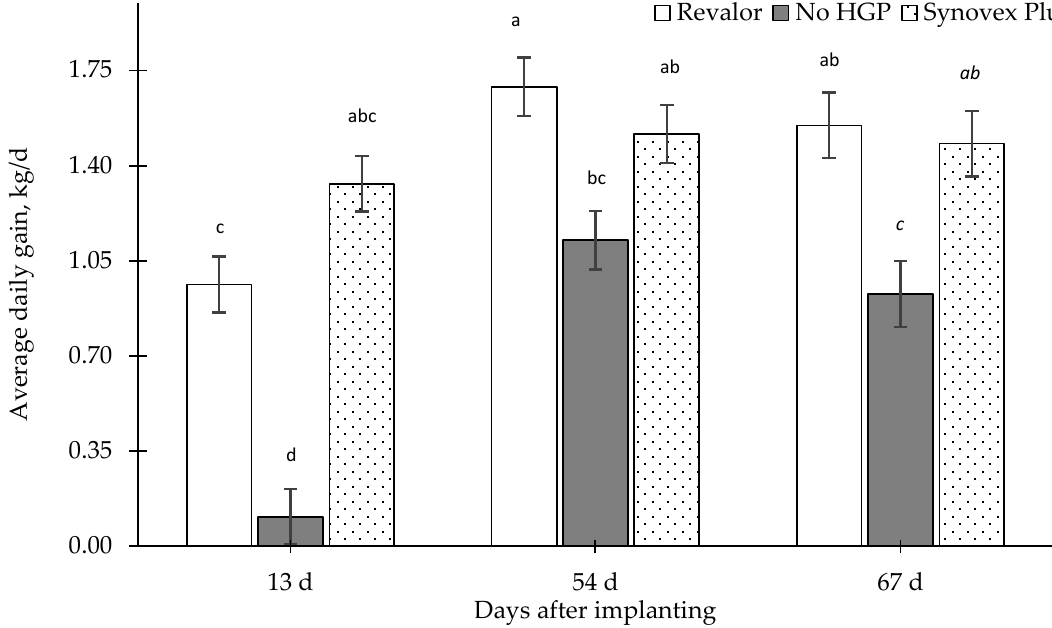
Figure 3. Average daily weight gains (kg/d) of steers according to the number of days after growth promoting implantation (SEM). Different letters indicate differences between groups according to Tukey’s test ( p < 0.05) (HGP = hormonal growth promoting).